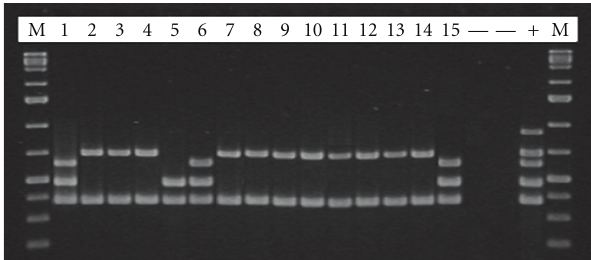
Figure 1: Multiplex PCR on isolated L. monocytogenes strains.